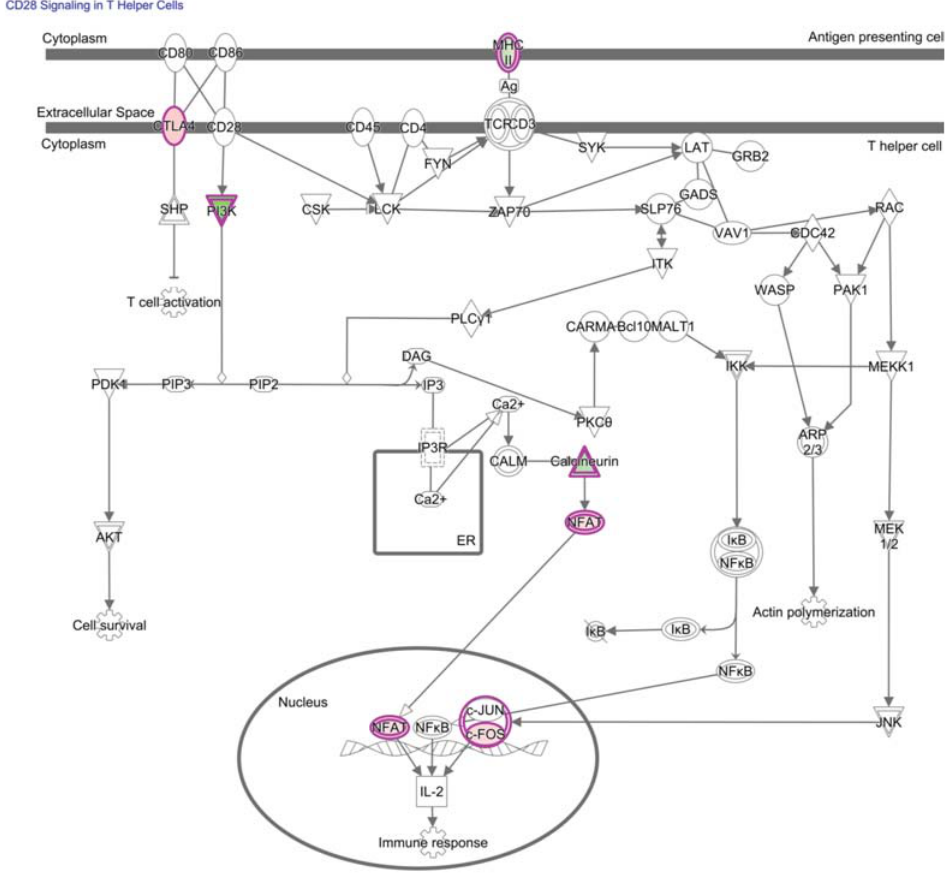
Figure 2. TAA-specific CD8+ T cells often lack co-stimulation for an immune response against tumors. CD28 signaling was reflected in a top canonical pathway predicted by genome-wide mRNA expression profiling to trend towards less activation in TAA-specific CD8+ T cells from the tumor compared to those in circulation ( p -value of overlap = 3.2E-4, right-tailed Fisher Exact Test, z-score = (cid:4)0.816). Many signaling pathways overlap between T cell subsets, so it is not surprising that a CD4+ T cell signaling pathway was associated with the gene expression of CD8+ T cells used to generate the figure above. Differential gene expression corresponding to molecules enriched in this pathway are outlined in purple with red fill representing overexpression and green fill representing decreased expression in T cells from the tumor relative to the periphery, and color intensity corresponds to the extent of expression difference. CD28 was predicted to be a key upstream regulator that is less active in TAA-specific CD8+ T cells from the tumor ( p -value of overlap = 1.3E-5, right-tailed Fisher exact test, activation z-score = (cid:4)0.696). CTLA-4 was also predicted to be an upstream regulator of differential gene expression ( p -value of overlap = 9.7E-5, right-tailed Fisher exact test). Differentially-expressed genes and corresponding fold-changes have been previously published and were reanalyzed through the use of QIAGEN’s Ingenuity ® Pathway Analysis (IPA ® , QIAGEN, Redwood City, CA, USA, www.qiagen.com/ingenuity) [35]. Both direct and indirect relationships were assessed in the Ingenuity knowledge base reference set with a confidence threshold of previous experimental observation in T cells. Note: The connecting arrow between SHP and T cell activation was altered to a line to better reflect inhibition downstream of